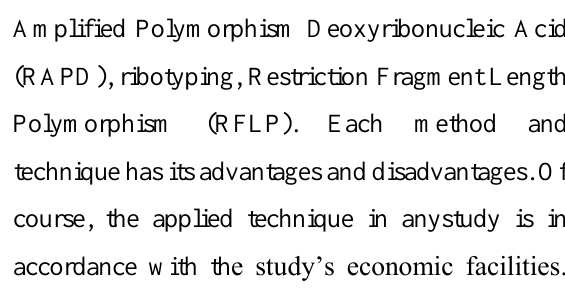
Fig 2. Enterobacterial Repetitive Intergenic Consensus Polymerase Chain Reaction Patterns of Some Escherichia coli